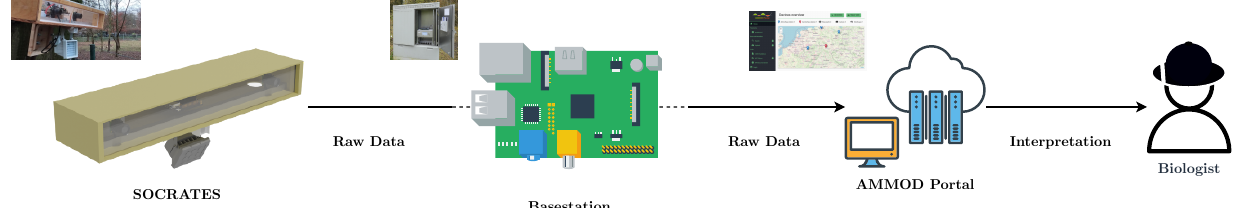
Figure 9. Fully automatic flow of data from SOCRATES over the base station to the AMMOD Portal and the expert end users. A GPU server runs the instance segmentation and distance estimation steps and uploads the results back to the AMMOD